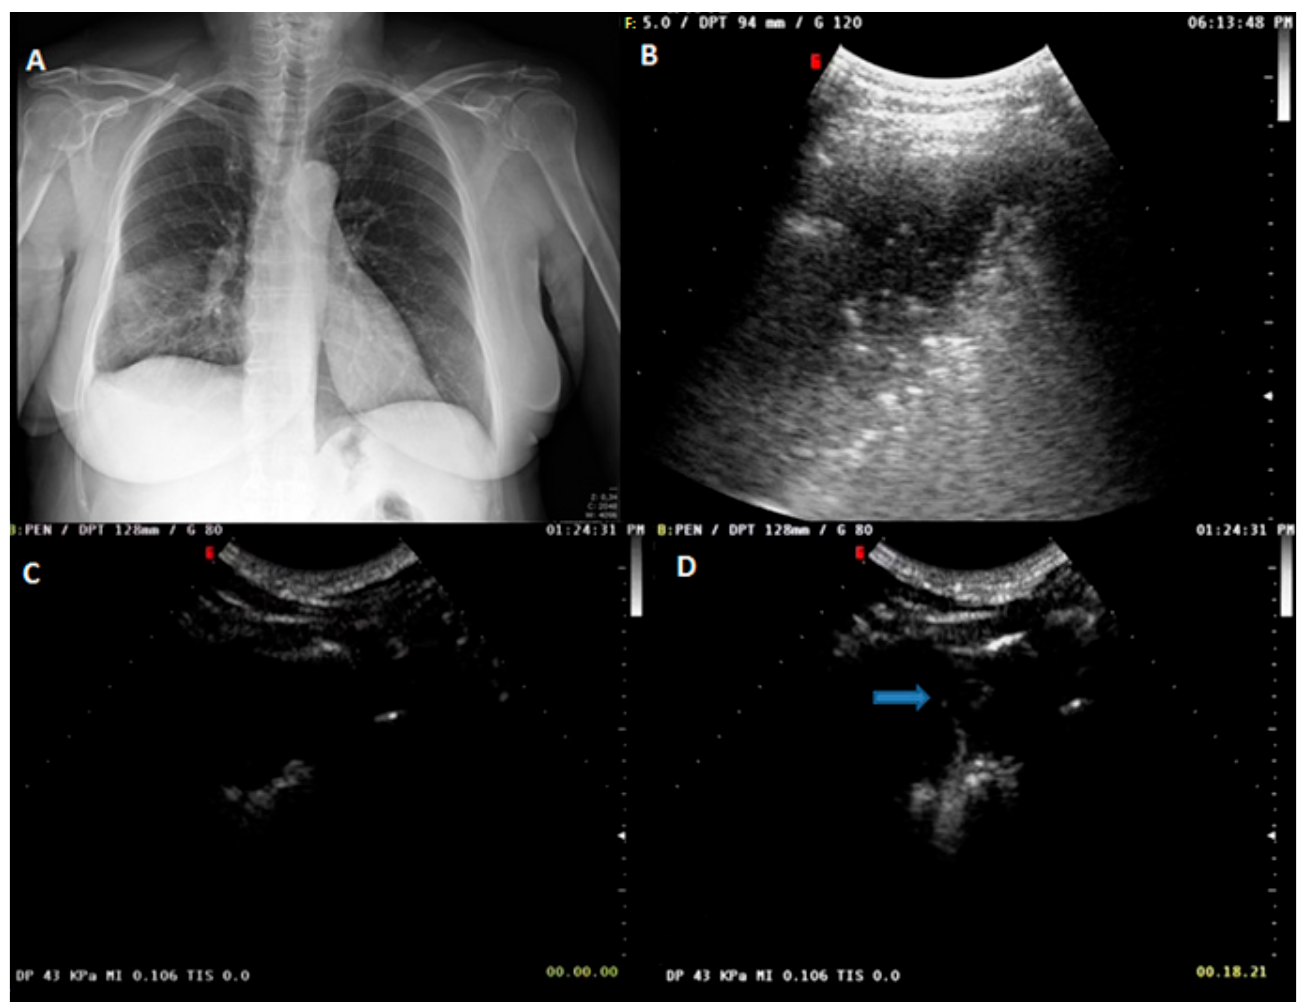
Figure 1. ( A ) Chest radiograph showing ill-defined patchy consolidation and ground glass opacities (GGO) in the right middle to lower lung zone. The clinical–radiological diagnosis was pneumonia. ( B ) US scan (thoracic pre-setting) in B-mode showing a hypoechoic subpleural pulmonary lesion with inner hyperechoic spots. ( C ) CEUS scan with SonoVue at 0 s showing no lesion perfusion. ( D ) CEUS scan with SonoVue at 18 s showing first spots of arrival of the ultrasound contrast agent (blue arrow).